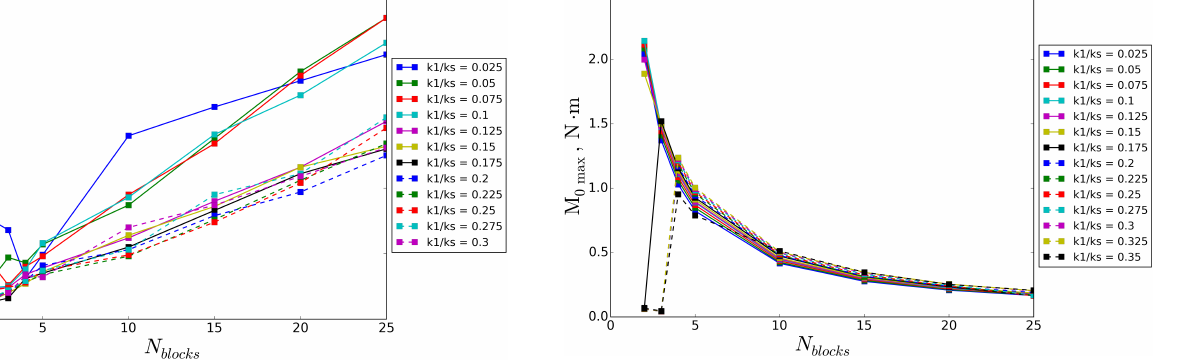
Figure 5. Cumulative number of events vs. number of blocks.